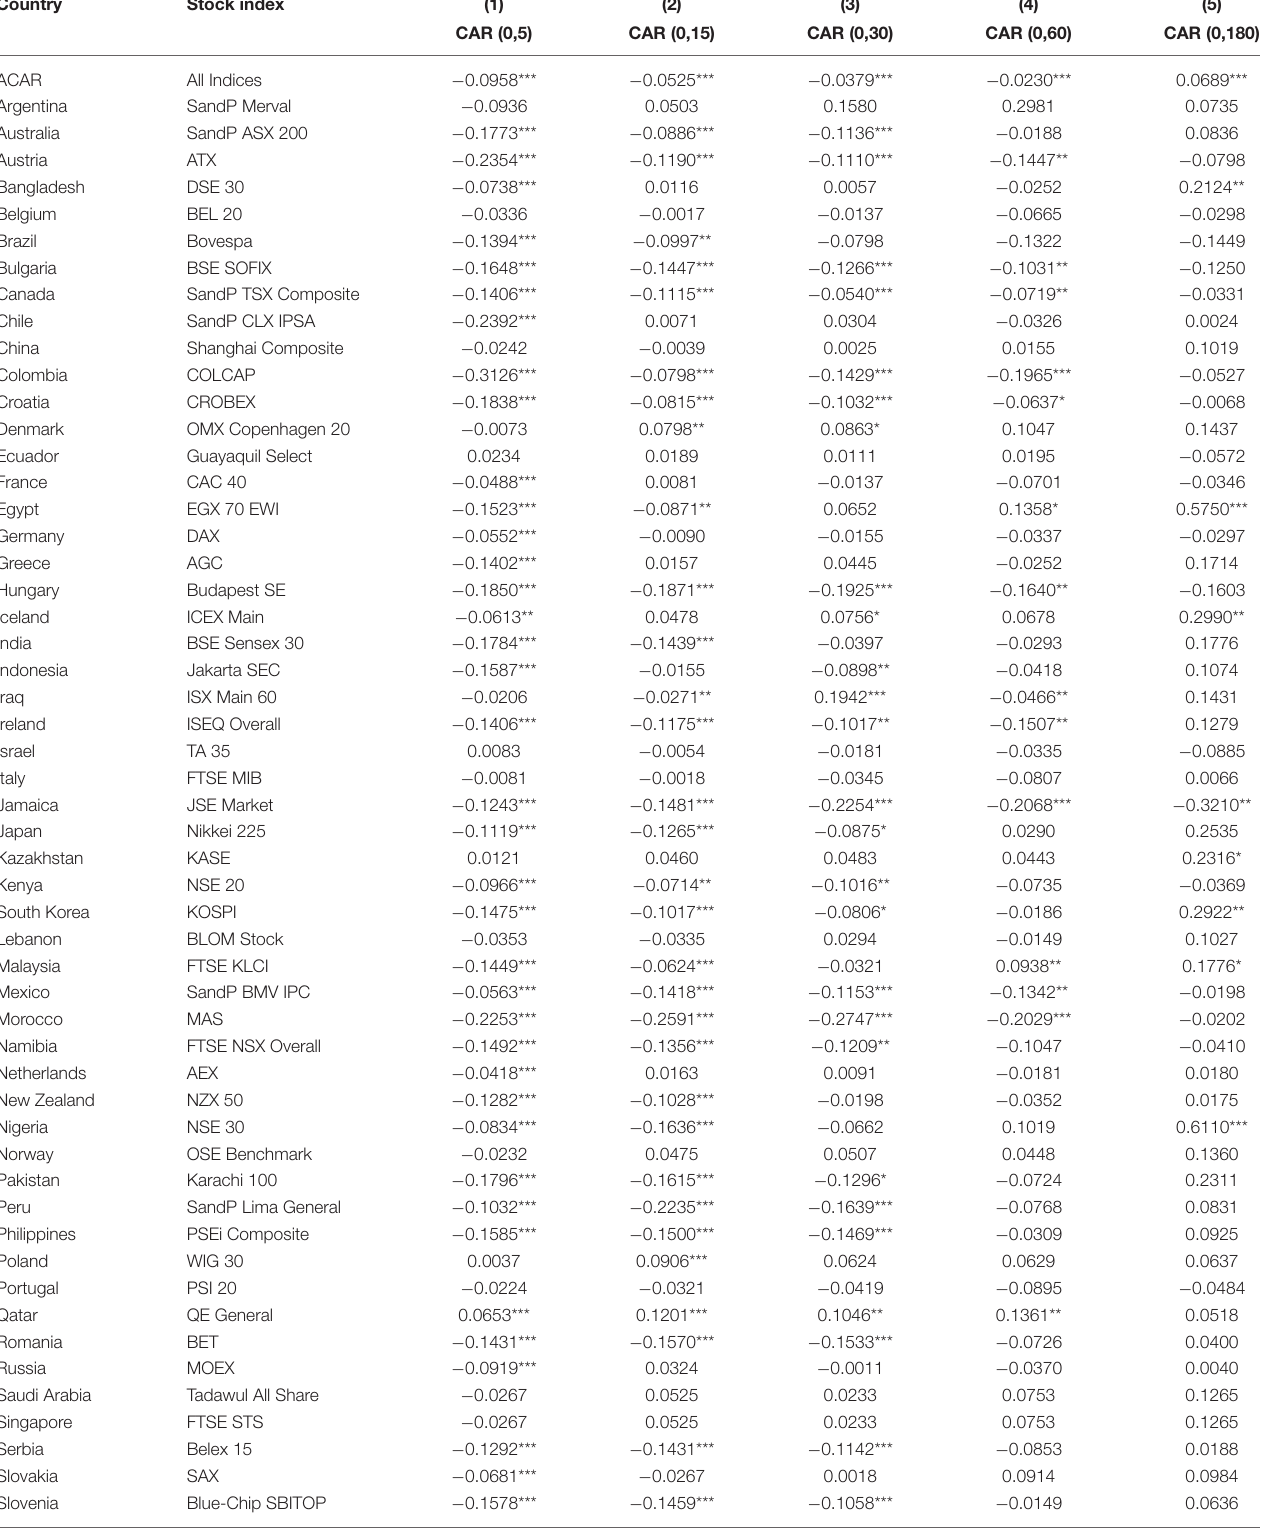
TABLE 4 | CARs for all stock market indices.